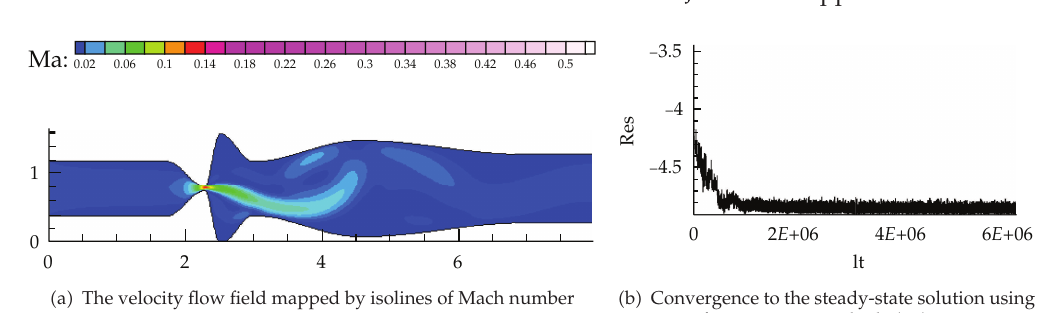
Figure 4: The initial condition computed in D 1 — M ∞ (cid:4) 0 . 012 , Re ∞ (cid:4) 4481 , p 2 (cid:4) 1 /κ , 450 × 100 cells, and M max (cid:4) 0 . 177 (cid:2) (cid:8) u max (cid:4) 60 . 7ms − 1 (cid:3)